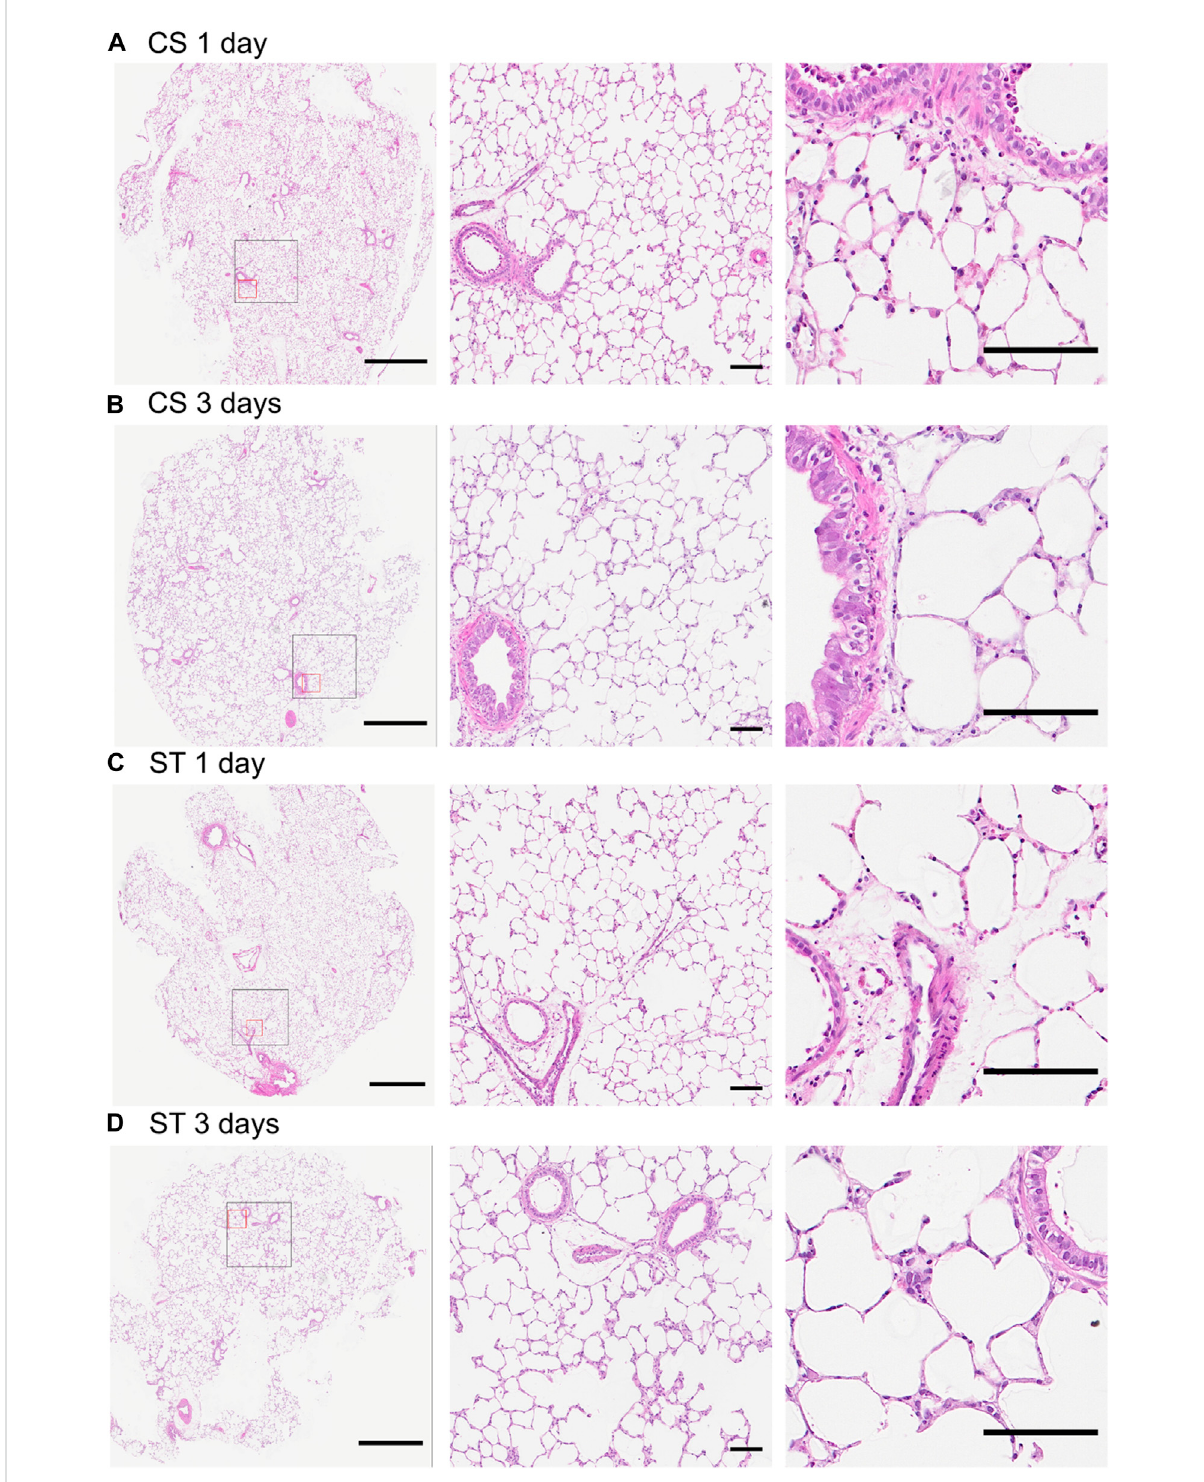
FIGURE 7 HematoxylinandeosinstainingofPCLSculturedundercyclicstretchorstaticconditions.Representativeimagesofstainedsectionsexposedto cyclic stretch (CS) for 1 (A) and 3 days (B) and static controls (ST) at these same timepoints ( (C,D) , respectively), including overview (left) and higher magni fi cation (center and right) images. The black and red squares in the overview image are displayed in higher magni fi cation to the right of the overview. Samples were retrieved after 1 and 3 days of stretch (2 and 4 days after slicing). Stained sections from two technical replicates from each experiment ( n = 3) and timepoint were evaluated. No difference between the timepoints nor between CS and ST groups were seen